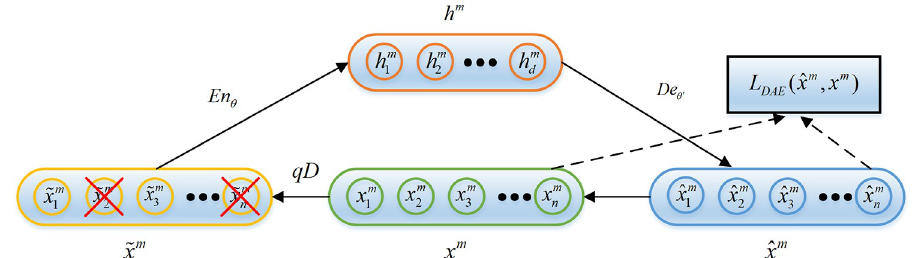
Fig 1. The structure principle of